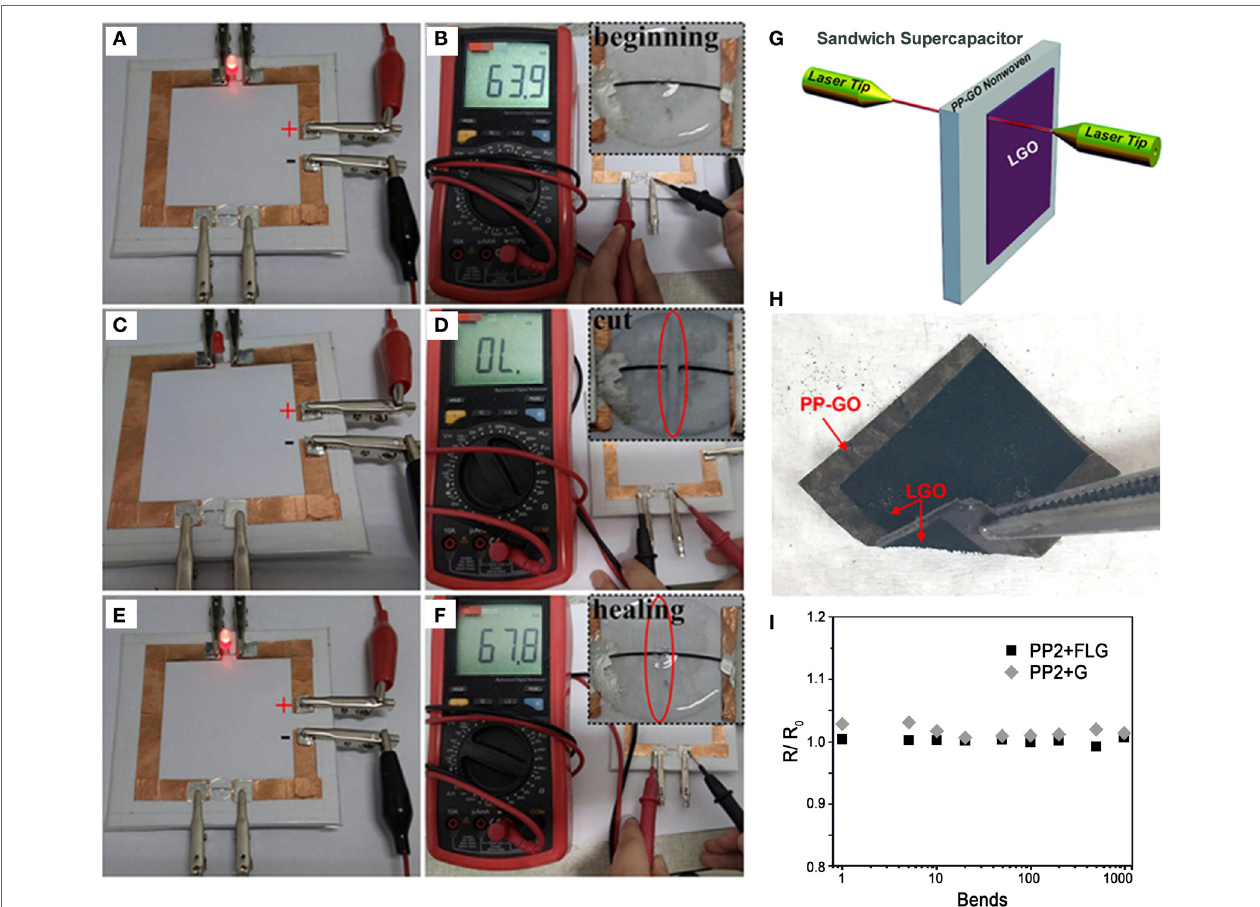
FiGUre 1 | (A–F) Self-healing properties of reduced graphene oxide-based composite fibers with polyurethane. Photographs of the fiber electrode within a circuit with a LED (A,c,e) and electrical resistance (B,D,F) of the fiber electrode before breaking, after breaking, and after healing. Adapted with permission from Wang et al. (2017) with permission from The American Chemical Society. (G,H) Scheme of laser-patterning process to fabricate monolithic sandwich supercapacitor on non-woven polypropylene (PP)-GO (G) and photograph of the PP-GO supercapacitor (H) . Adapted from Pan et al. (2017) with permission from The American Chemical Society. (i) Variation of resistance during bending cycles with bending radius of 5 mm for PP fabrics covered with monolayer (PP2 + G) and few-layer graphene (PP2 + FLG). Adapted from Neves et al. (2017) with permission from Nature Publishing